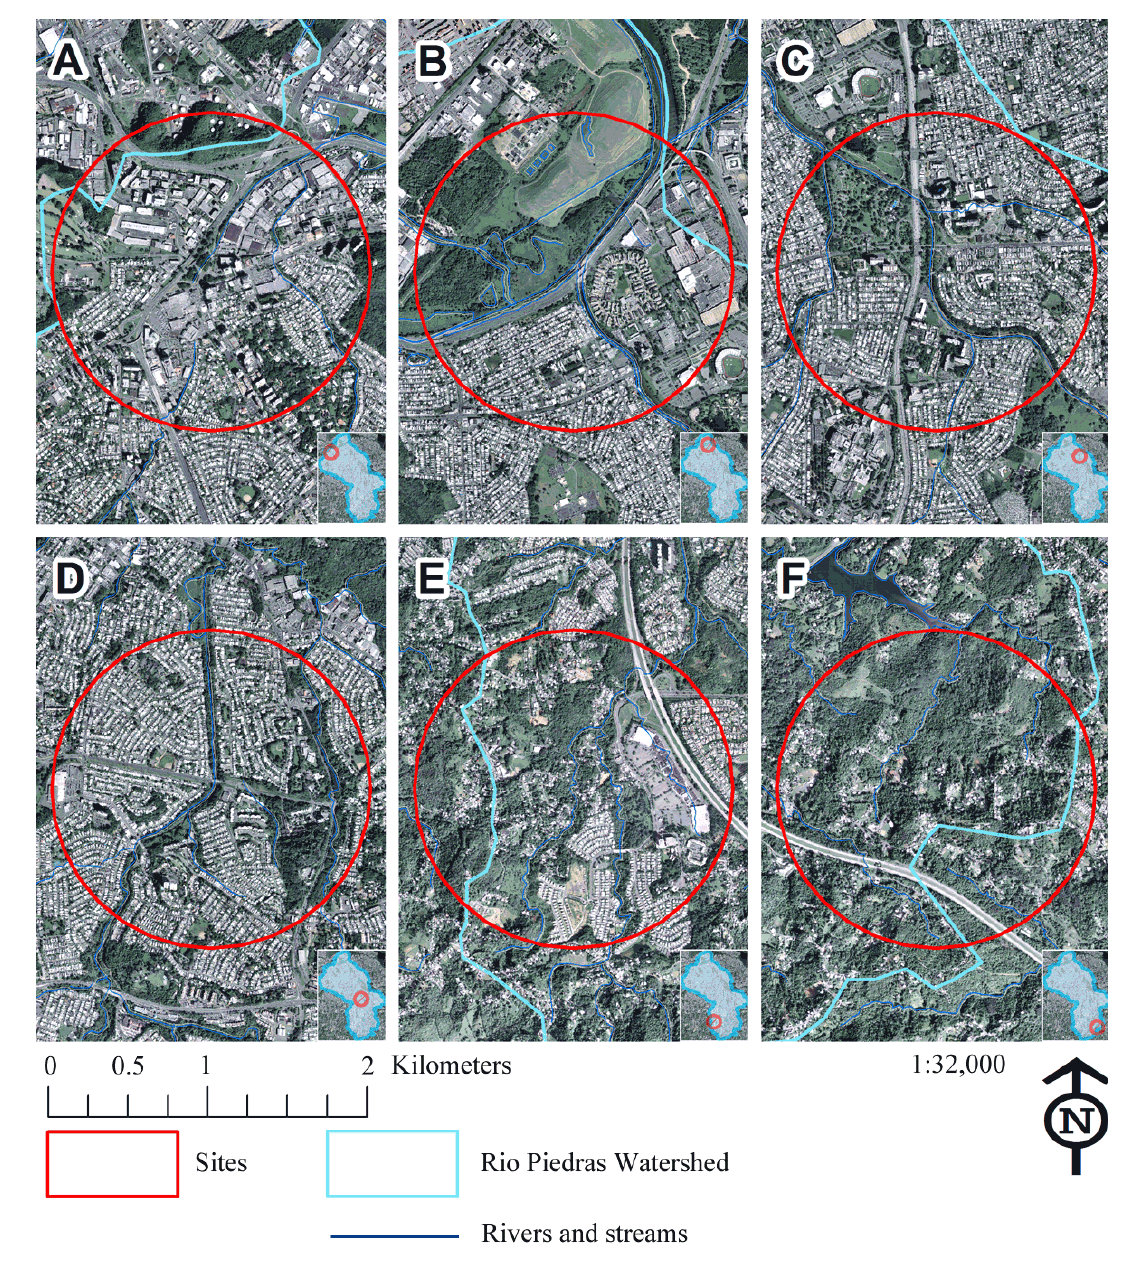
Fig. 2 . Aerial views of six monitoring areas across the Río Piedras watershed providing a visual assessment of their urban morphologies. A. San Patricio, B. Puerto Nuevo, C. Avenida central, D. La Sierra, E. Chiclana, F. Cupey.